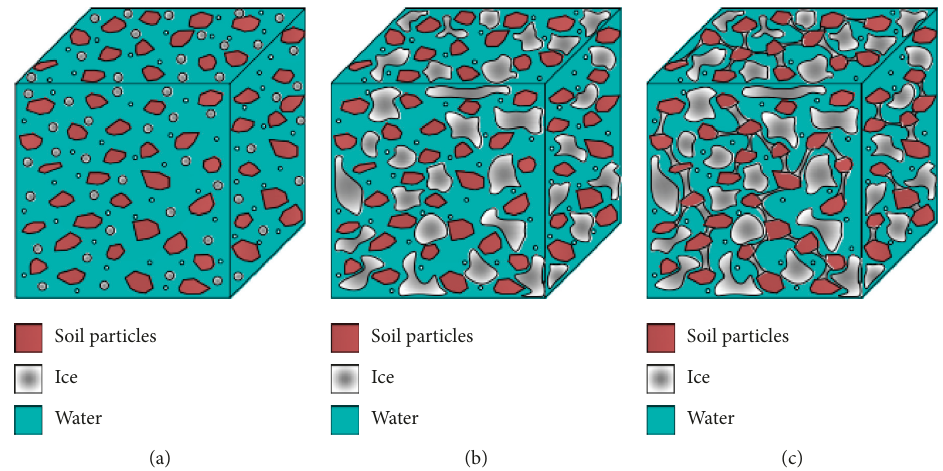
Figure 1: Schematic of the structure of ice and solid particles in frozen soil. (a) Dispersed. (b) Ice skeleton. (c) Contact cementation.